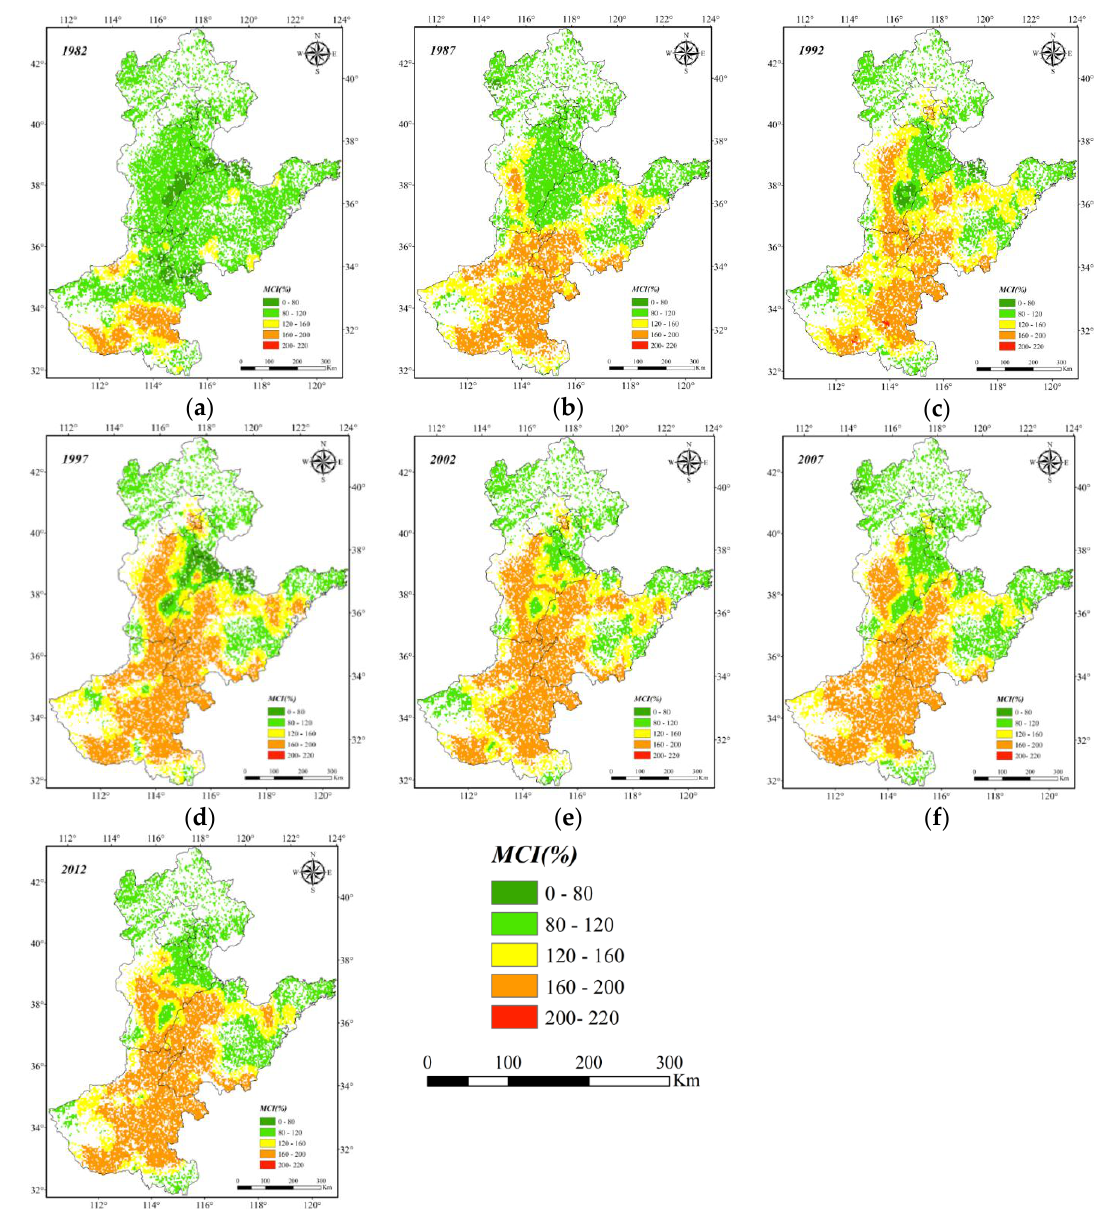
Figure 5. Distribution of Multiple Cropping Indices in the North China Plain from 1982 to 2012. ( a ) 1982; ( b ) 1987; ( c ) 1992; ( d ) 1997; ( e ) 2002; ( f ) 2007; ( g ) 2012.